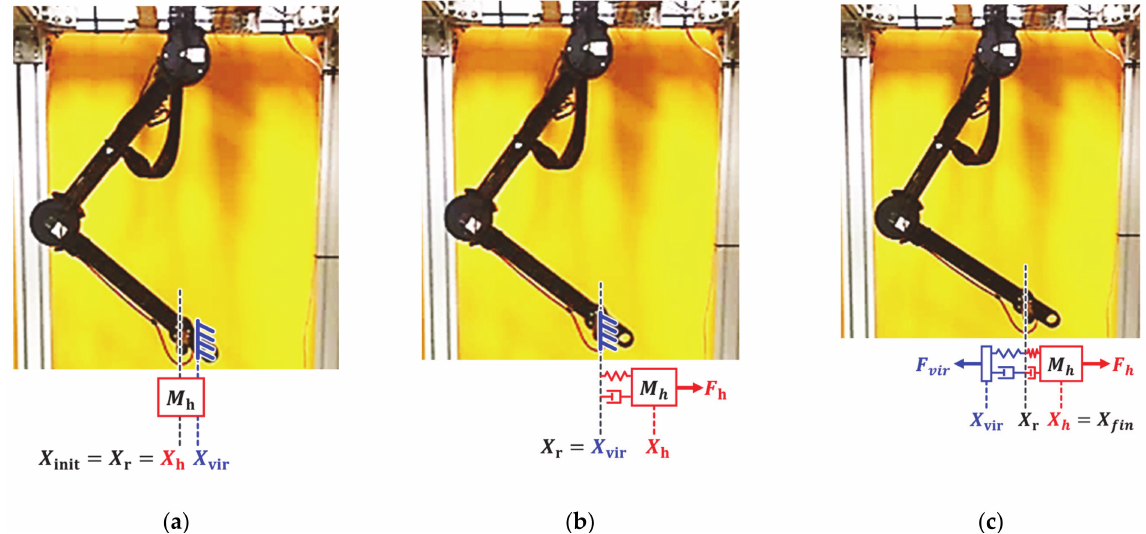
Figure 11. Experimental setup for virtual object collision. ( a ) Starting position. ( b ) Motion with constant speed. ( c ) Collision with virtual object.